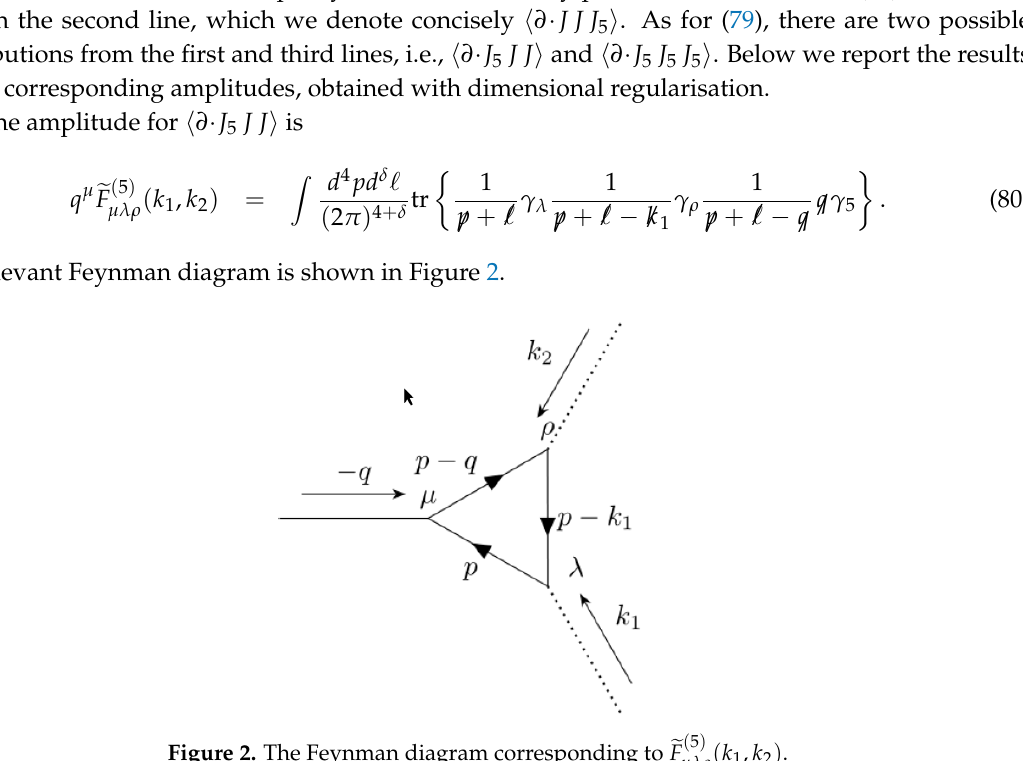
Figure 2. The Feynman diagram corresponding to (cid:101) F